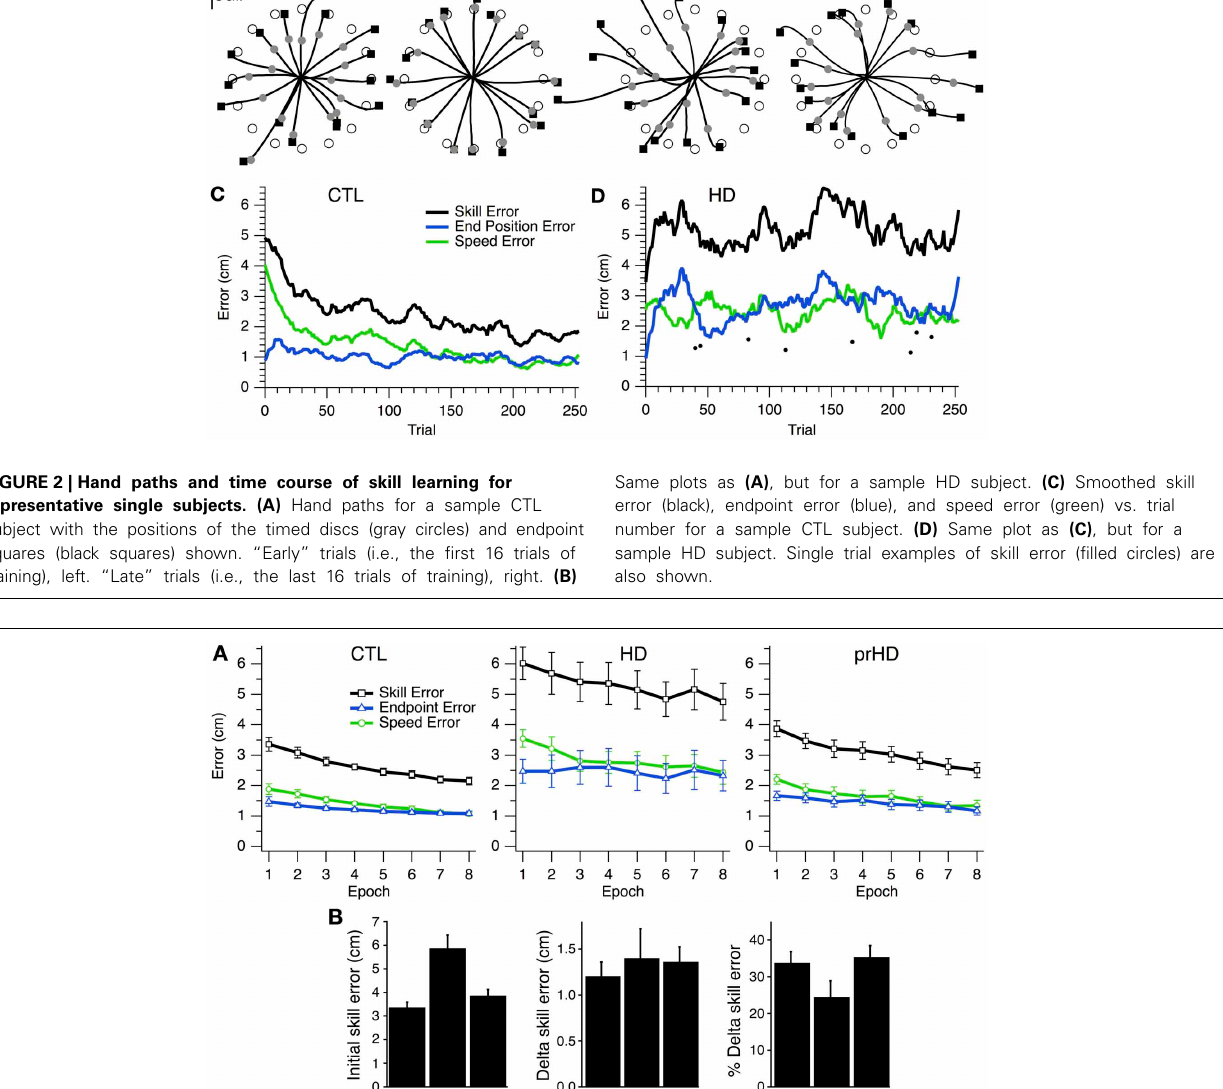
(32 trials each) for the CTL (left), HD (middle) and prHD (right) groups. (B) Group averages (mean ± SE) of initial skill error, delta skill error and percent delta skill